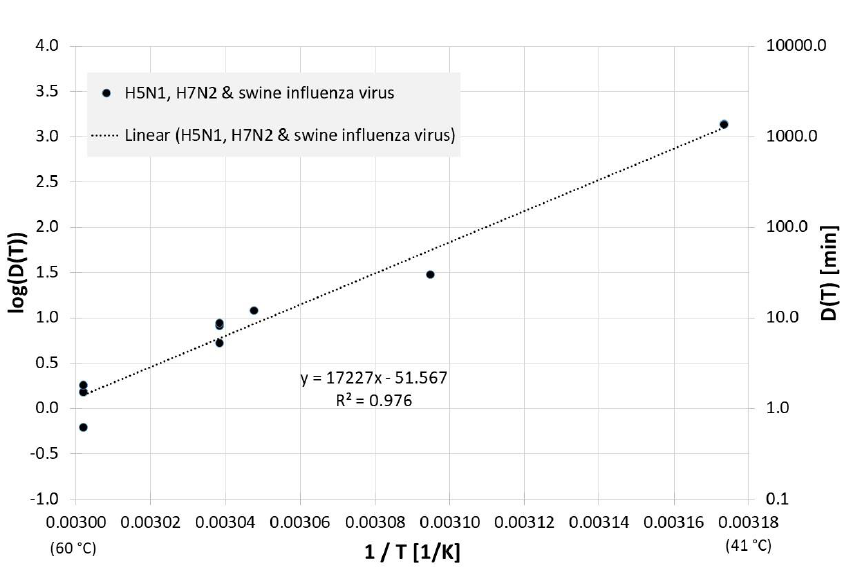
Figure 11. Correlation between 1/T and log(D(T)) for all published influenza virus thermal inactiva- tion data in manure, litter and feces along with the linear regression curve. For better understanding, D(T) is also given on the right Y-axis in a logarithmic scale.